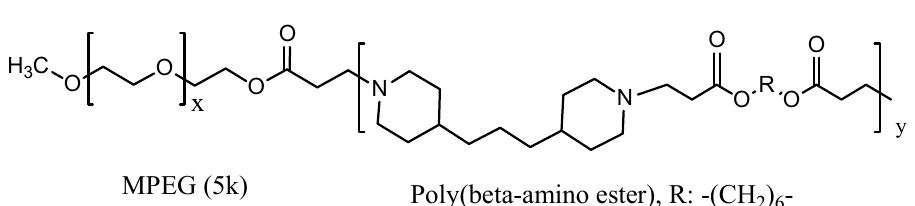
Figure 11. Conjugation of protoporphyrin IX to PEG-PLA.